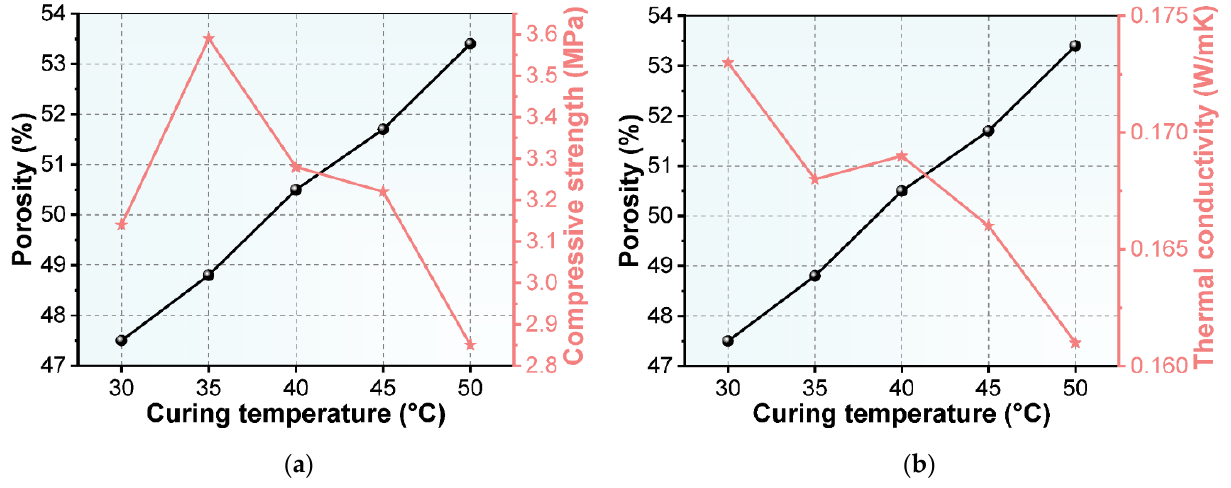
Figure 7. ( a ) Porosity and thermal conductivity of NAAC at different curing temperatures; ( b ) porosity and compressive strength of NAAC at different curing temperatures.